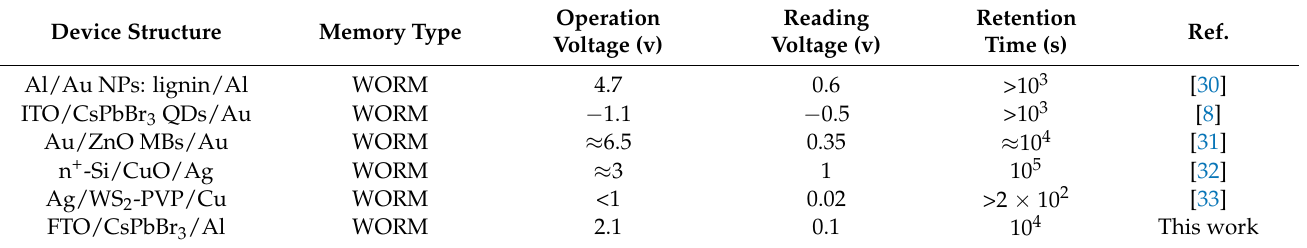
Figure 6. The retention characteristics the of FTO/CsPbBr 3 /Al memory device. Table 1. A brief summary of the WORM performance based on our research and other studies.